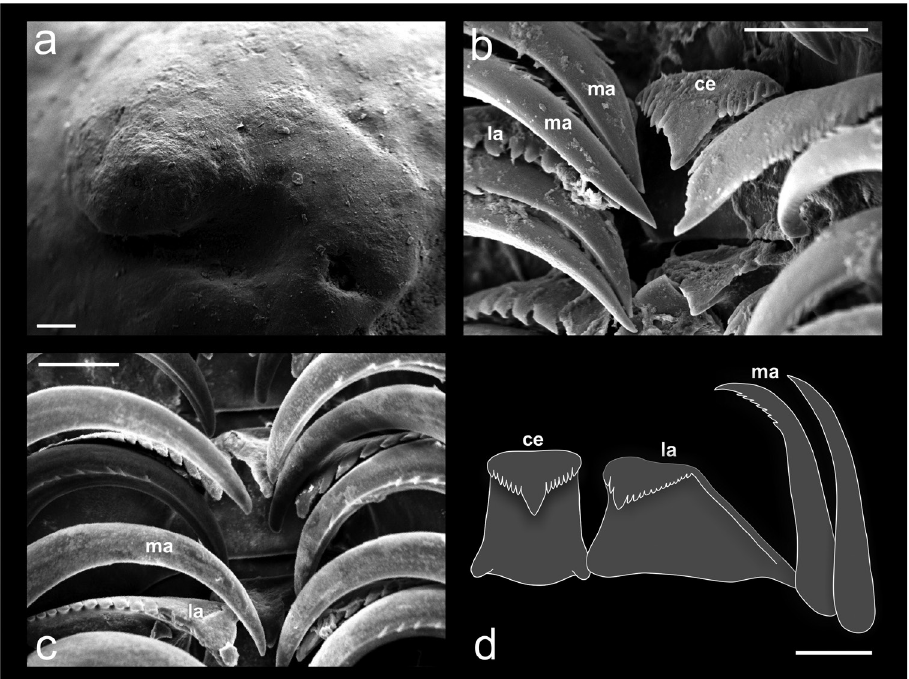
Figure 6. Protoconch and radula of Calyptraea aurita . a protoconch in apical view b SEM showing teeth in folded position c SEM showing teeth in folded position d radular structure. Abbreviations: ce: central tooth; la: lateral tooth; ma: marginal tooth. Scale bar: 100 μm ( a ), 50 μm ( b, c, d